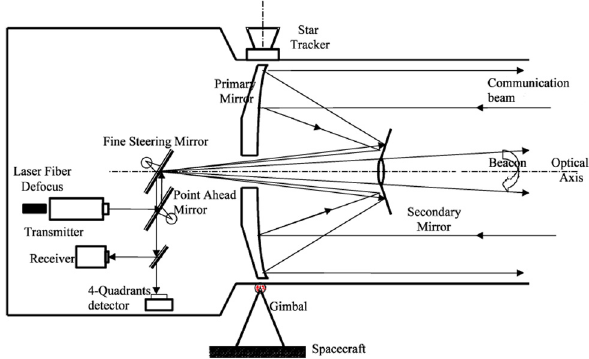
Figure 1: Transceiver diagram of the optical and mechanical struc - ture [ 22 ]